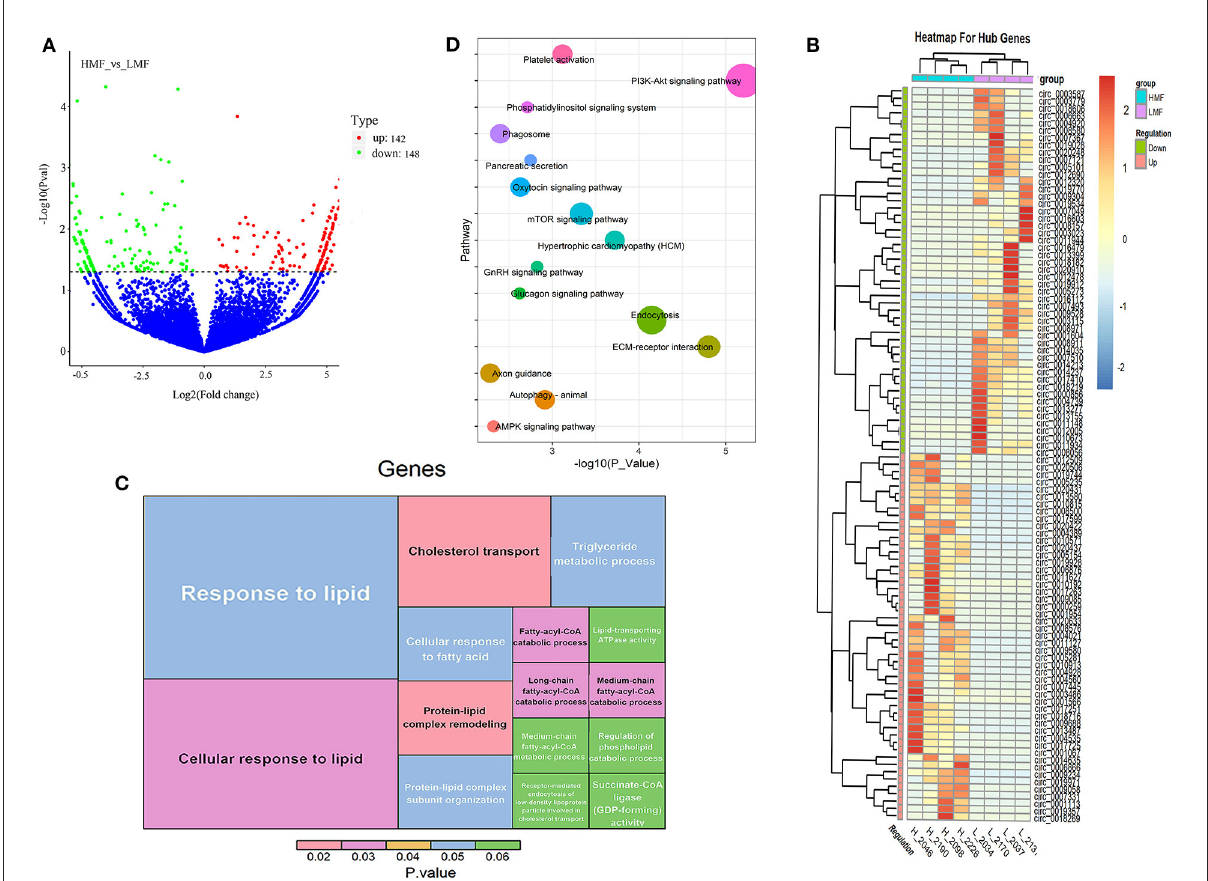
FIGURE2 Expression and functional enrichment analysis of DE-circRNAs. (A) Volcano plots reveal the abundance of circRNAs in mammary epithelial cells of cows in the HMF and LMF groups. (B) Clustering of the 100 circRNA expression profiles with the most remarkable differences between the HMF and LMF groups. (C) Significantly enriched DE-circRNAs and lipid metabolism-related GO term (each lattice represents a term, the size of the lattice area represents how many genes are enriched for that term, and color represents significance). (D) DE-circRNAs were enriched in signaling pathways related to lipid metabolism (the size of the dots represents how many genes are enriched in that